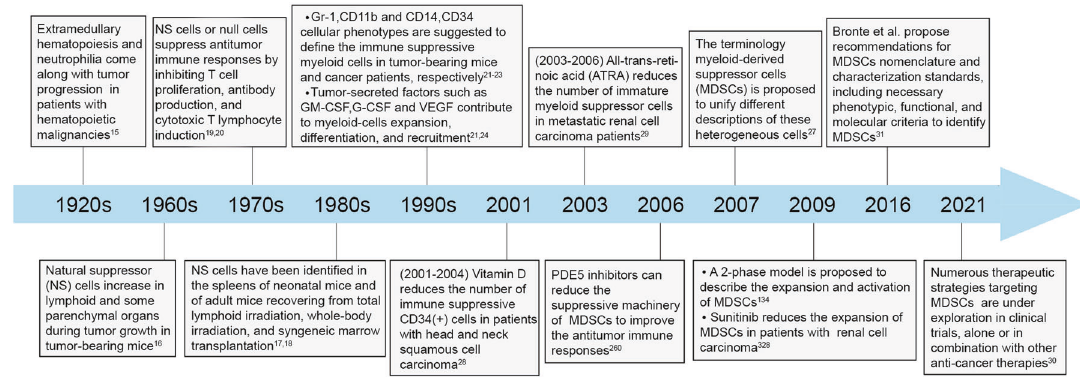
Fig. 1 Historical progression in the investigation of